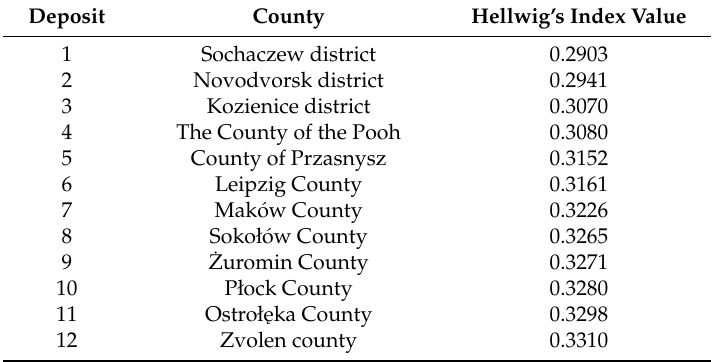
Table 2. Synthetic